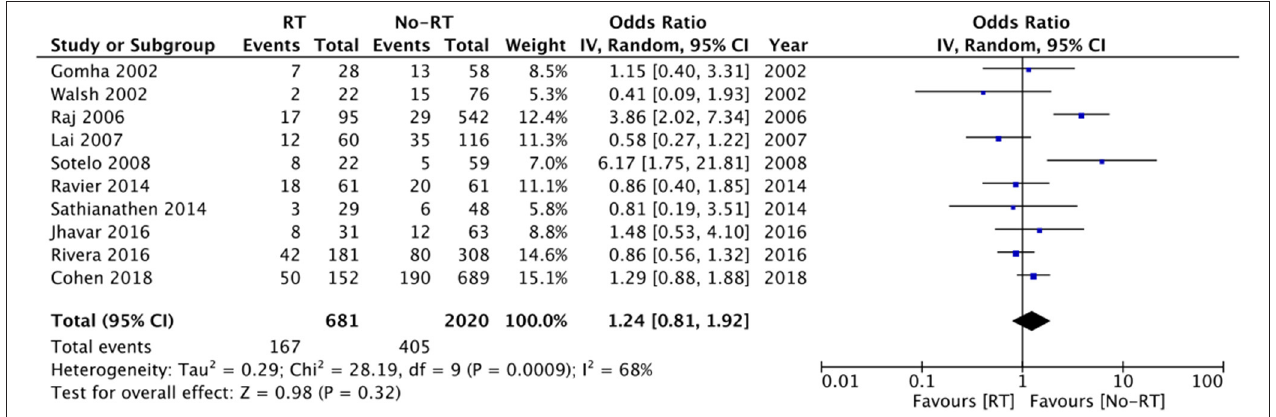
FIGURE 3 | Meta-analysis of revision surgery between RT and no-RT